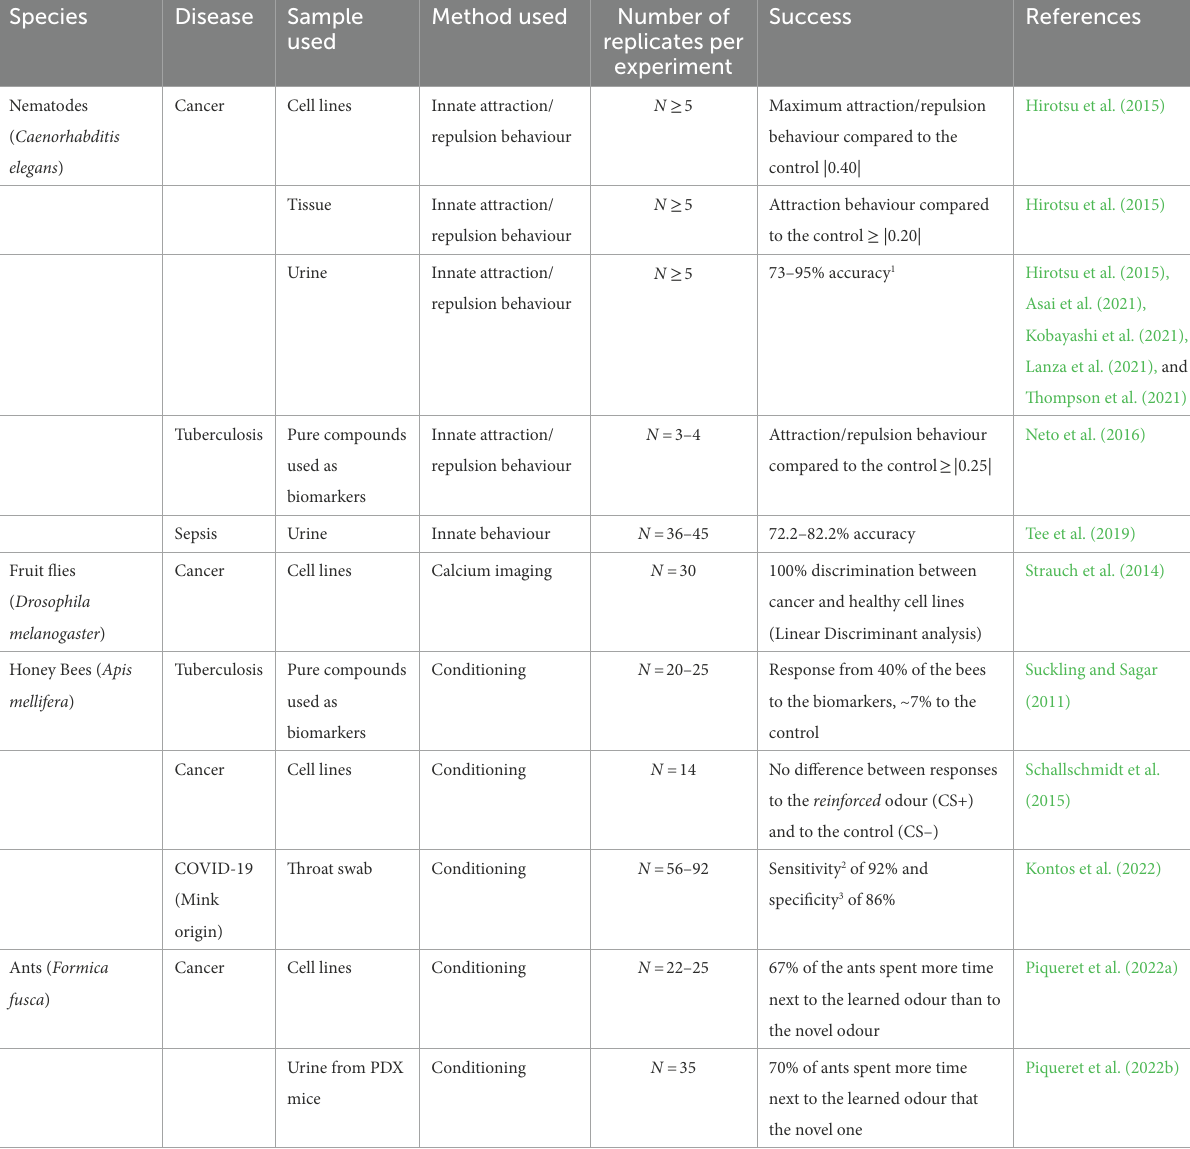
TABLE 1 List of invertebrate species tested for human related disease